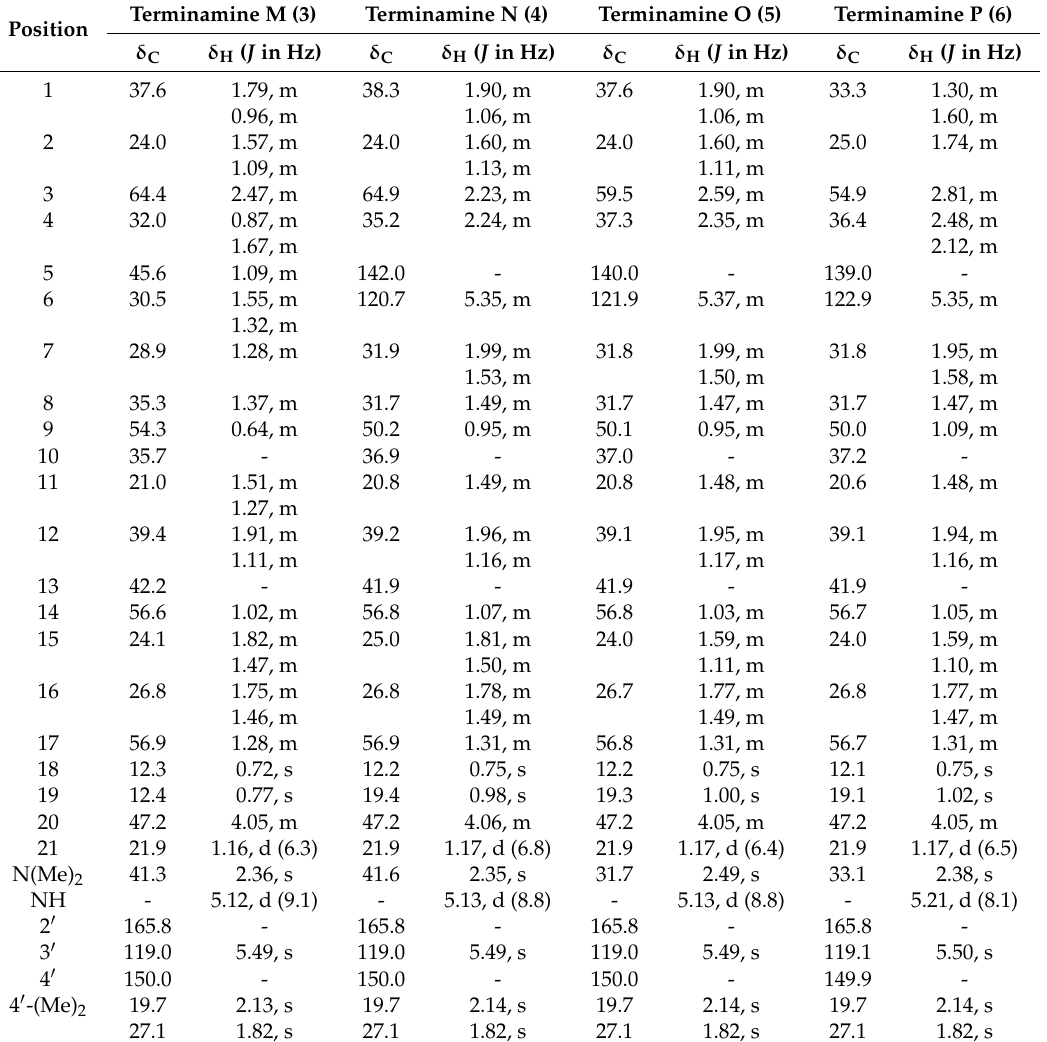
Table 2. NMR Spectroscopic data (400 MHz, CDCl 3 ) for Terminamine M-P ( 3 – 6